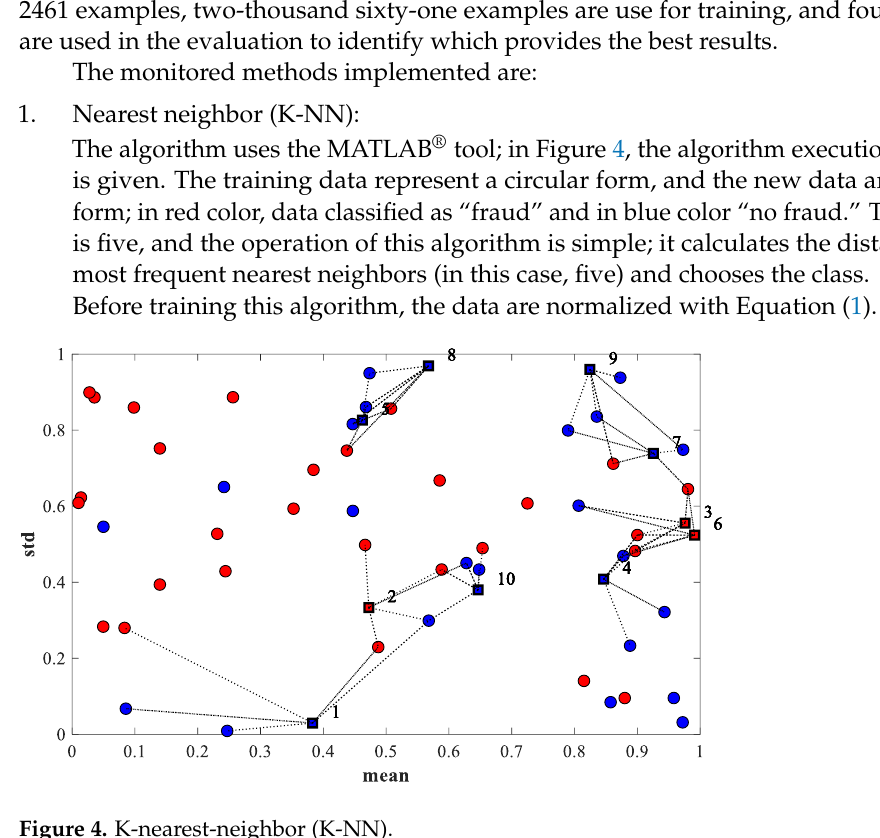
Figure 4. K-nearest-neighbor (K-NN).